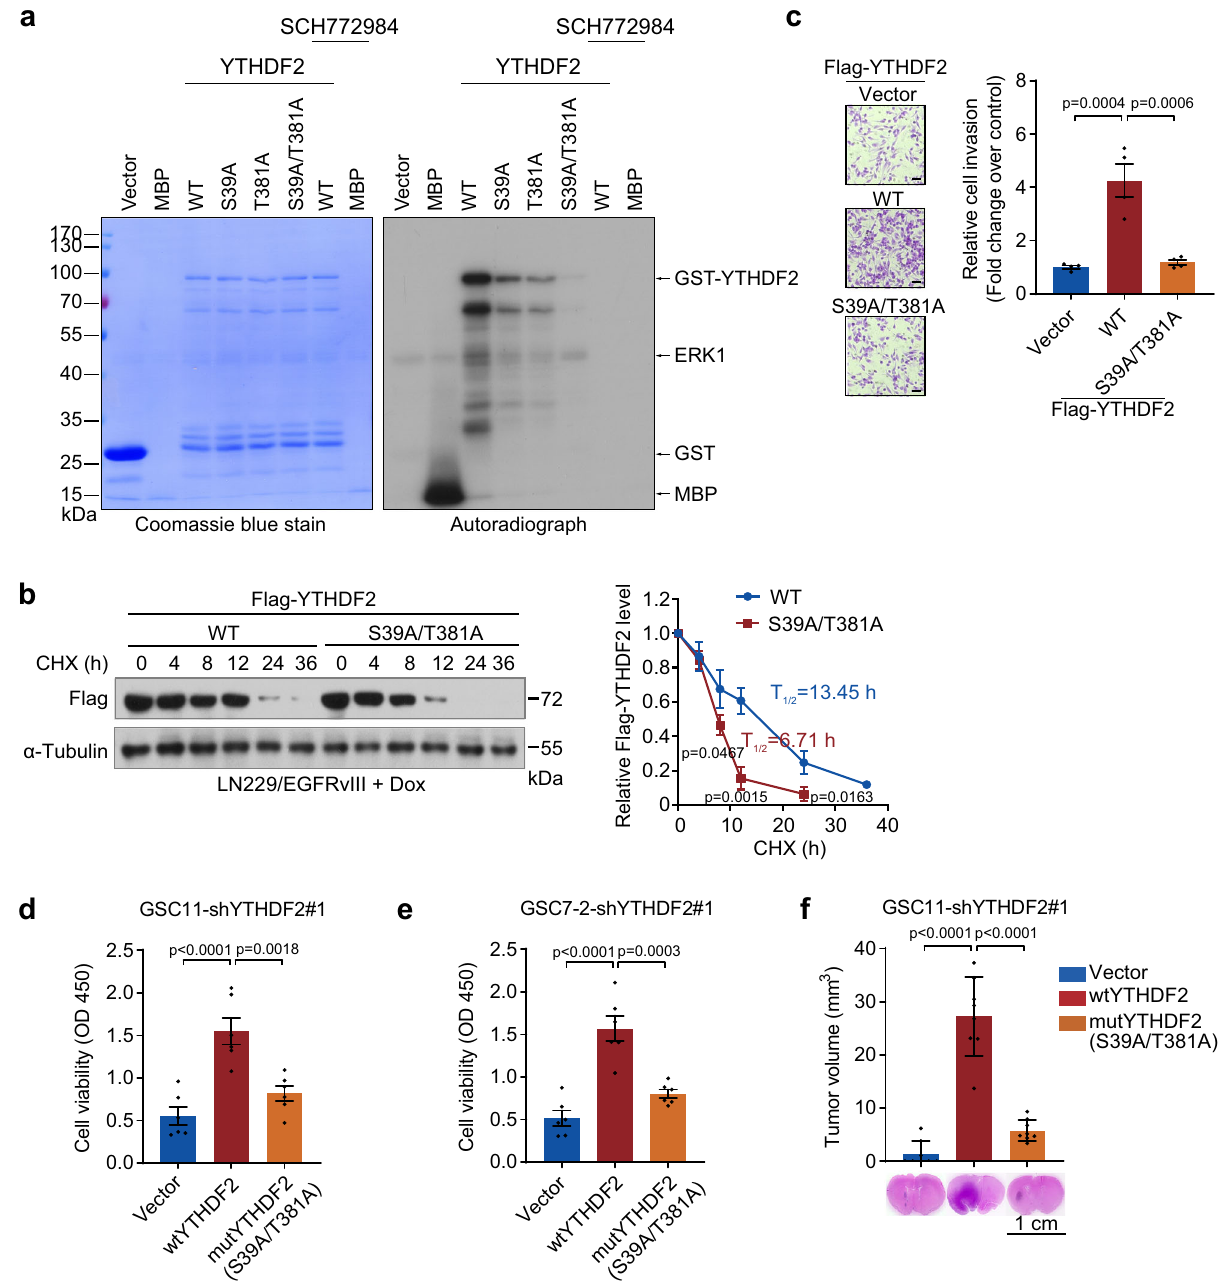
Fig. 4 ERK1/2 phosphorylates YTHDF2 at serine 39 and threonine 381 to stabilize YTHDF2. a In vitro kinase assay of GST-YTHDF2. Recombinant active ERK1 and wild type (WT), S39A, T381A, or S39A/T381A YTHDF2 were incubated in the presence of [ γ - 32 P] ATP. Proteins were separated by SDS-PAGE, transferred to PVDF membrane and autoradiography performed. MBP was included as positive control and co-incubated with SCH772984 as negative control. Coomassie blue stain was shown as loading control. Representative image of three independent experiments. b Stability of wild type or S39A/ T381A mutated Flag-YTHDF2 was measured by CHX (50 μ g/mL) chase assay in LN229/EGFRvIII cells cultured with Dox (10 μ g/ml) (left panel) and analysis of YTHDF2 protein lifetime (right panel). Data are mean ± S.D. of three independent experiments. (unpaired two-sided t test). c In vitro invasion assay for LN229 cells transfected with wild type or S39A/T381A mutated Flag-YTHDF2. Representative invasion images of the cells (left panel) and quantitation of relative cell invasion (right panel). Data are mean ± S.E.M., n = 4 biologically independent experiments (one-way ANOVA Tukey ’ s post hoc test). Scale bar = 50 μ m. d , e Cell viability of wild type or S39A/T381A mutated YTHDF2 expressing GSC11 ( e ) or GSC7-2 ( f ) cells with YTHDF2 depletion was measured by CCK-8. Data are mean ± S.E.M., n = 6 biologically independent experiments (one-way ANOVA Tukey ’ s post hoc test). f Nude mice intracranial tumor assay using wild type or S39A/T381A mutated YTHDF2 expressing GSC11 cells with YTHDF2 depletion. Brain sections stained with H&E show representative tumor xenografts. Tumor volumes were calculated using the formula V = ab 2 /2, where a and b are the tumor ’ s length and width, respectively. Data are mean ± S.D., n = 8 mice per group examined over two independent experiments (one-way ANOVA Tukey ’ s post hoc test). Source data are provided as a Source data fi